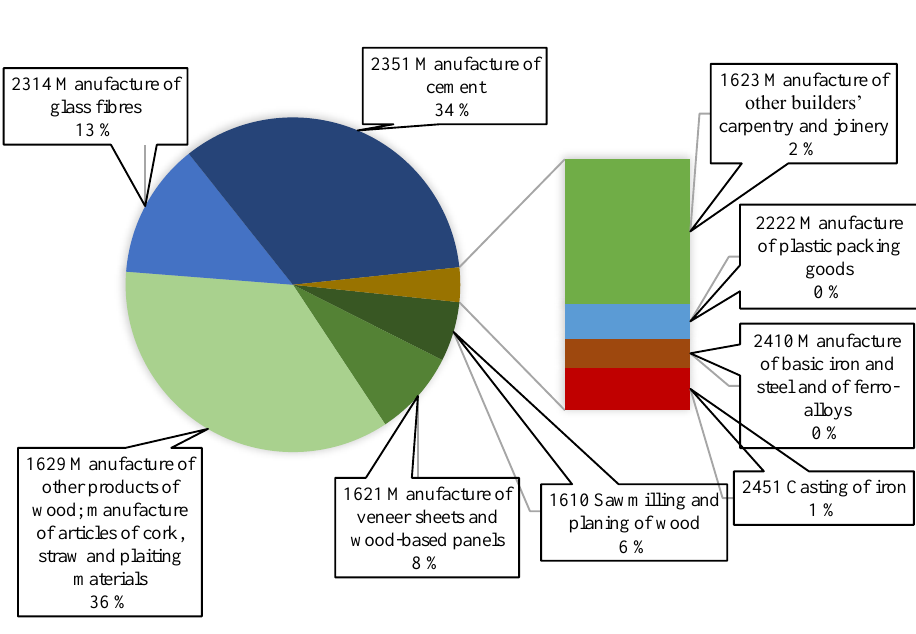
Fig. 9 . Breakdown of reimbursement of mandatory procurement levies between industrial segments in Latvia